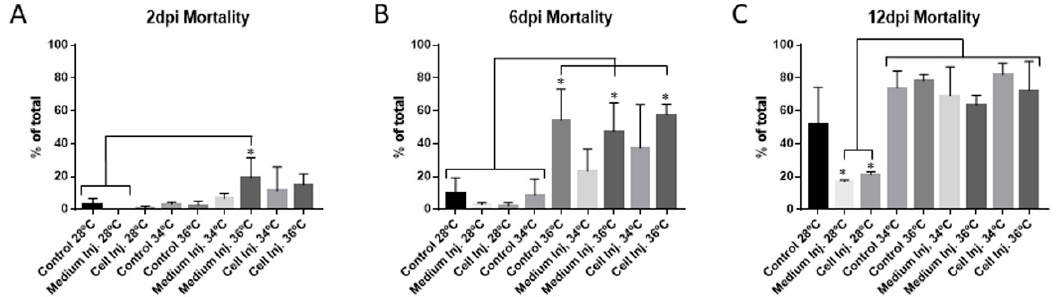
Figure 2. Mortality quantification at different time points comparing the different incubation conditions of the zebrafish embryos. ( A ) Mortality quantified at 2 dpi. ( B ) Mortality quantified at 6 dpi. ( C ) Mortality quantified at 12 dpi. Parameters are expressed as percentages from the total number of embryos assayed for each condition, comparing the incubation of the embryos from 2 dpi to 12 dpi at 28 °C, 34 °C and 36 °C. Error bars represent the standard deviation (SD). One-way ANOVA was performed, and differences were considered significant when * p < 0.05 (n 28 °C = 150, n 34 °C = 150, n 36 °C = 120). The experiment has been performed in triplicate.